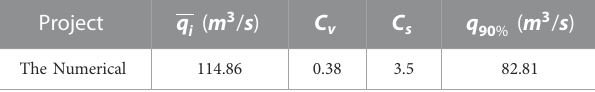
TABLE 3 P-III curve wiring